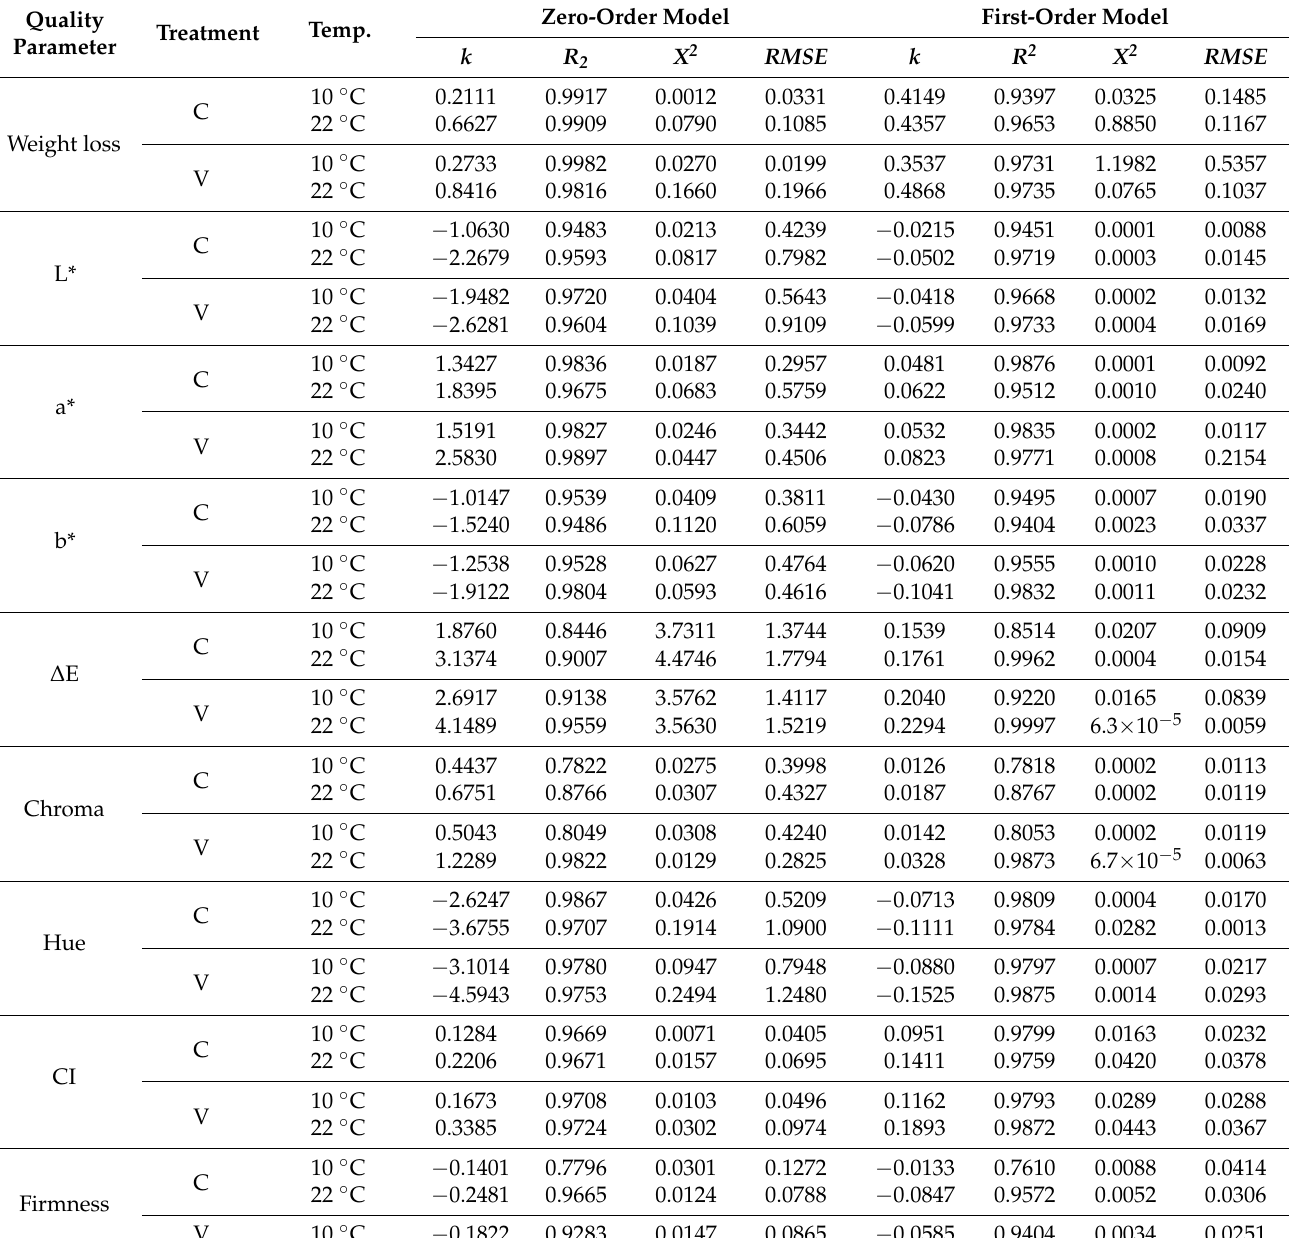
Table 2. The statistical values of zero-order and first-order models of control and vibrated tomato groups were stored at 10 ◦ C and 22 ◦ C for 10 days storage